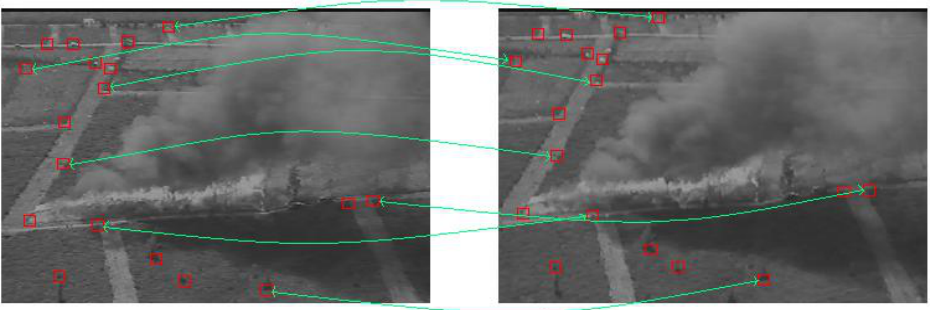
Figure 5. Feature extraction and association in two consecutive aerial visual images.